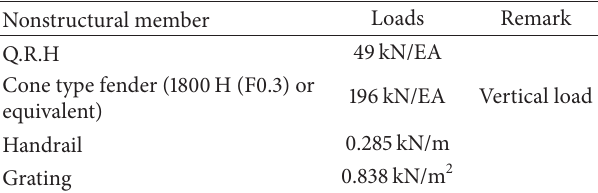
Table 4: Appurtenance loads.